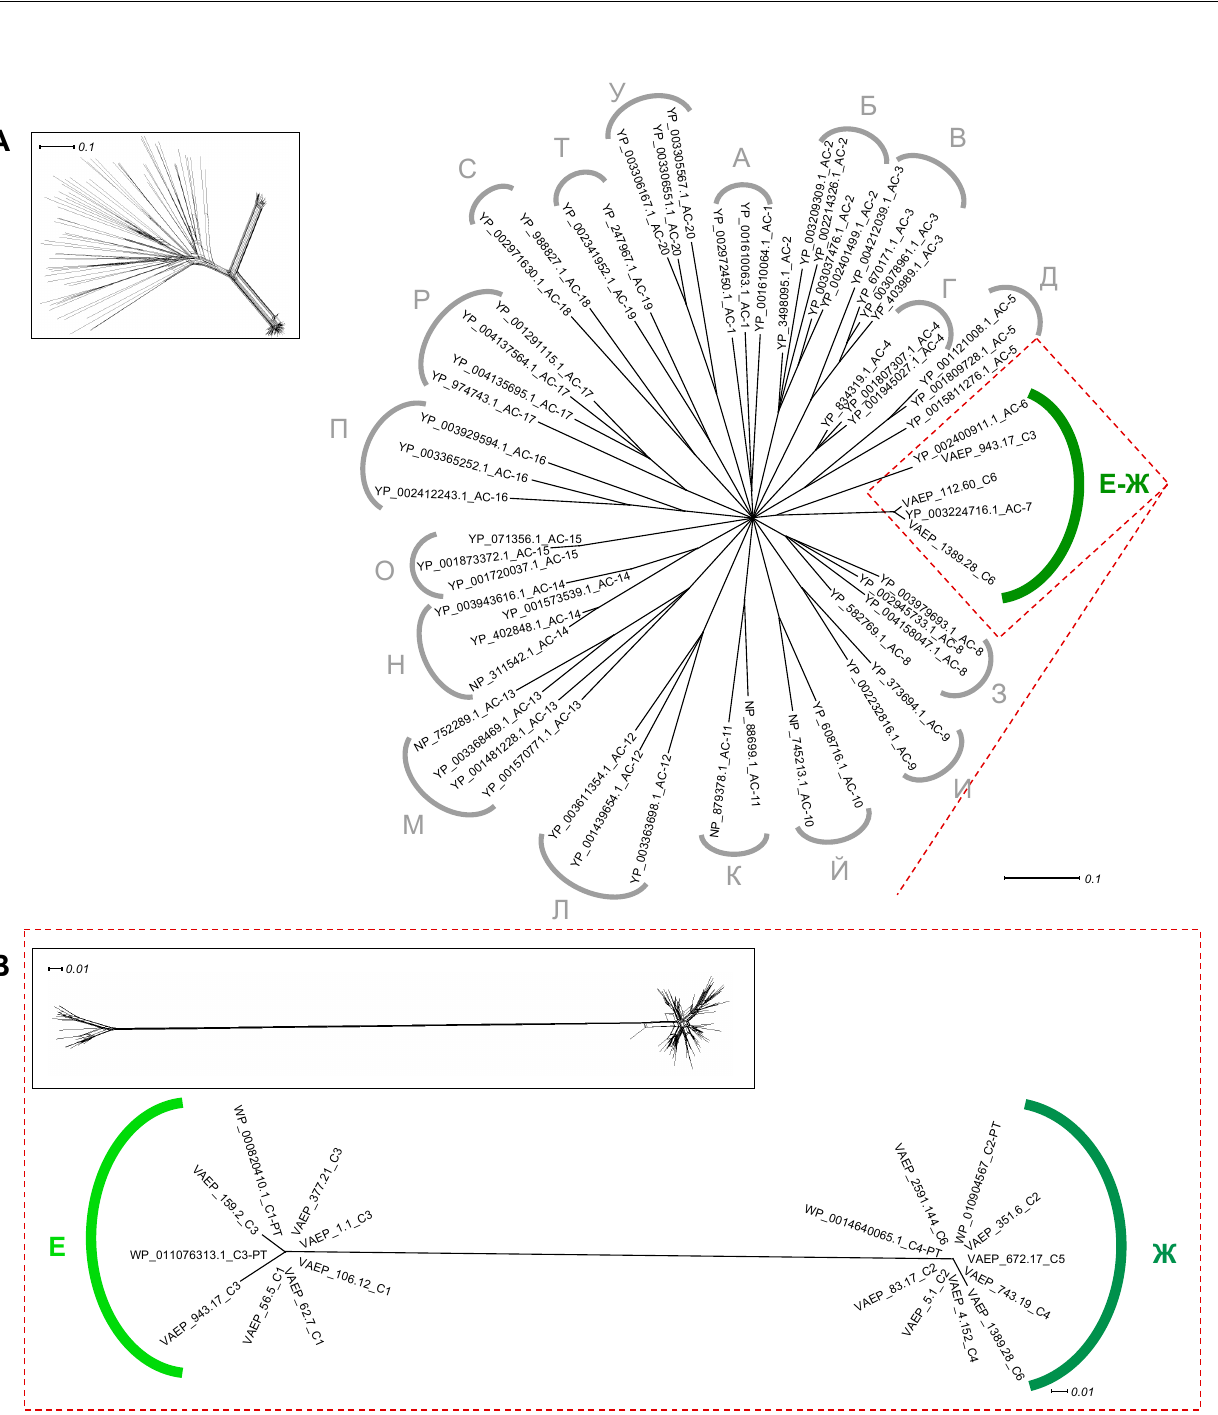
Figure 6. Phylogenetic analysis of the AC1 in Ag43. Trees were generated using SplitsTree; inserts represent the trees before applying bootstrapping and confidence threshold. ( A ) AC1 from Ag43 respective to the different clusters previously reported in ATs, namely from A to У (Cyrillic alphabet) [26]. ( B ) Phylogenetic analyses of the AC1 from Ag43 only. For legibility, sequences that were identified but have not been included here are available in Table S1. Scale bars represent the evolutionary distance.